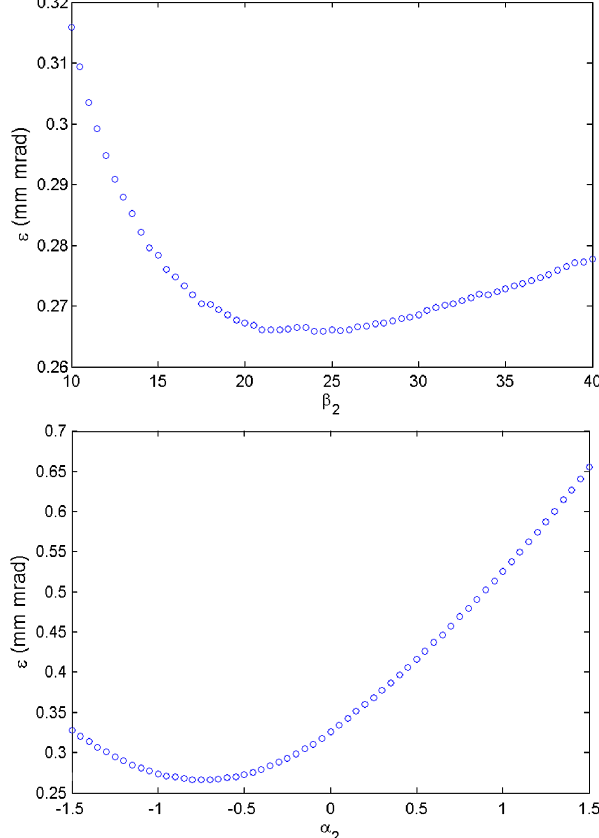
attained when (cid:4) x ¼ 22 : 5 m and (cid:5) x ¼ (cid:1) 0 : 85